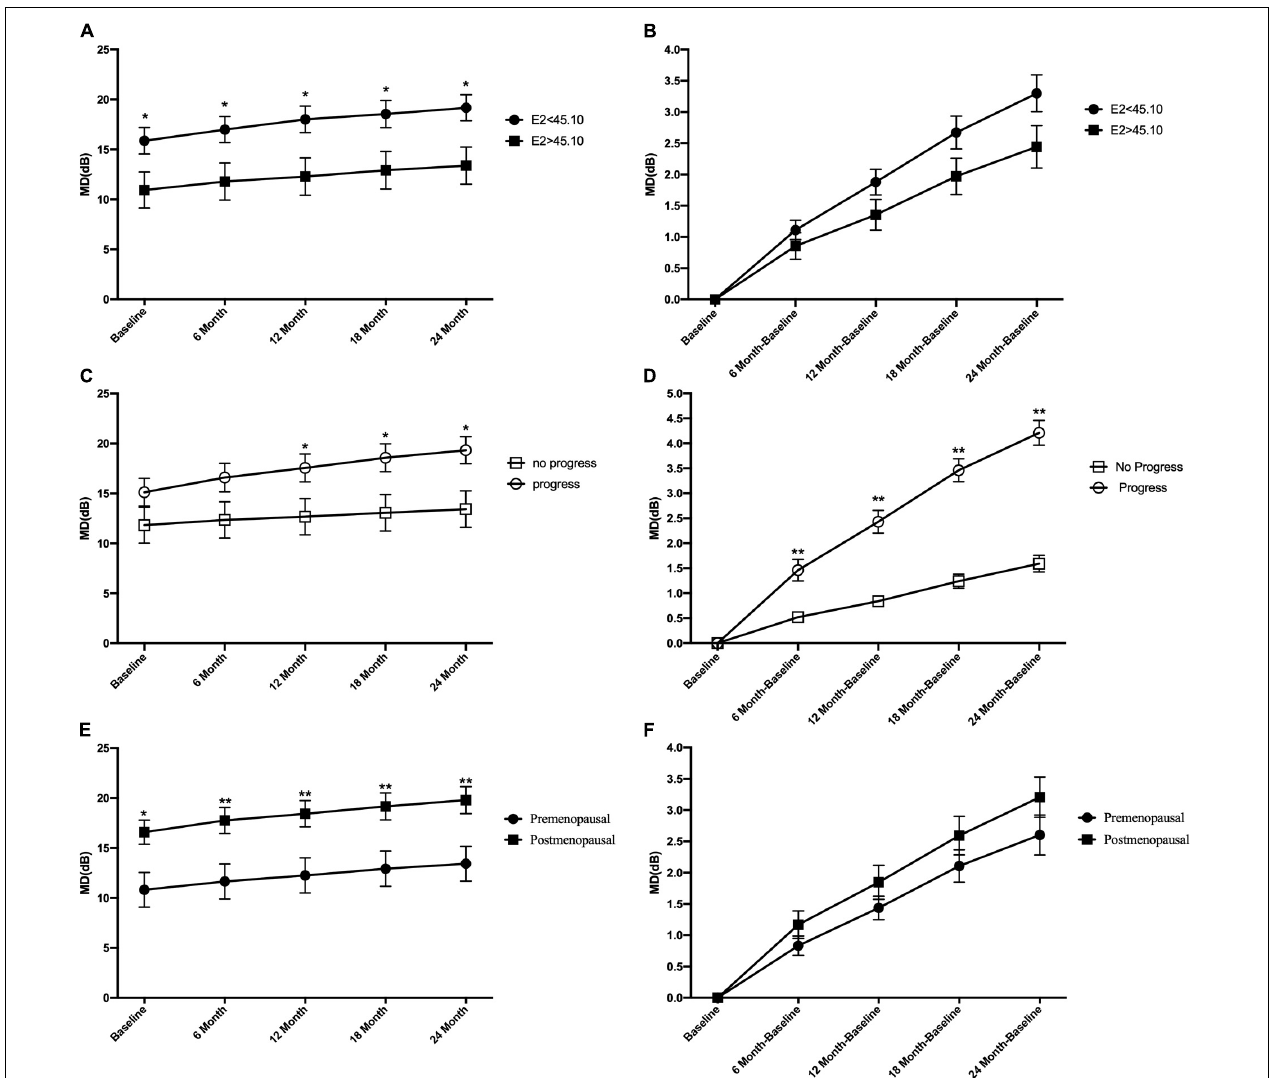
FIGURE 2 | Comparison of the mean level of visual field mean deviation (MD) and mean change of visual field mean deviation between groups at the different follow-up time points. At baseline and all time points during follow-up period, the mean level of MD in E2 < 45.1 and E2 > 45.1 group (A) , in progression and no progression groups (C) , and in premenopausal and postmenopausal groups (E) . The mean change of MD in E2 < 45.1 and E2 > 45.1 group (B) , in progression and no progression groups (D) , in premenopausal and postmenopausal groups (F) . E2, 17- β -estradiol; MD, mean deviation; * p < 0.05, ** p <